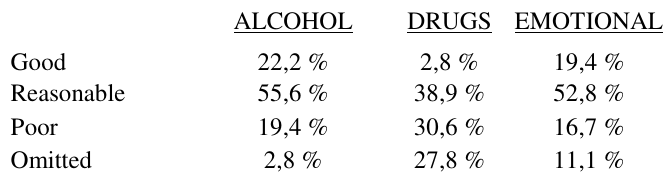
RATING OF SUCCESS IN DEALING WITH PROBLEMS